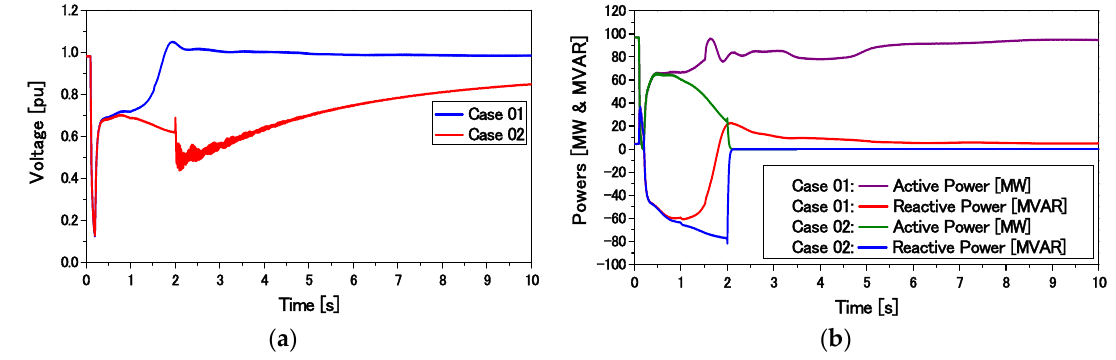
Figure 24. Reactive power output of wind generators: ( a ) DFIG; ( b ) SCIG.